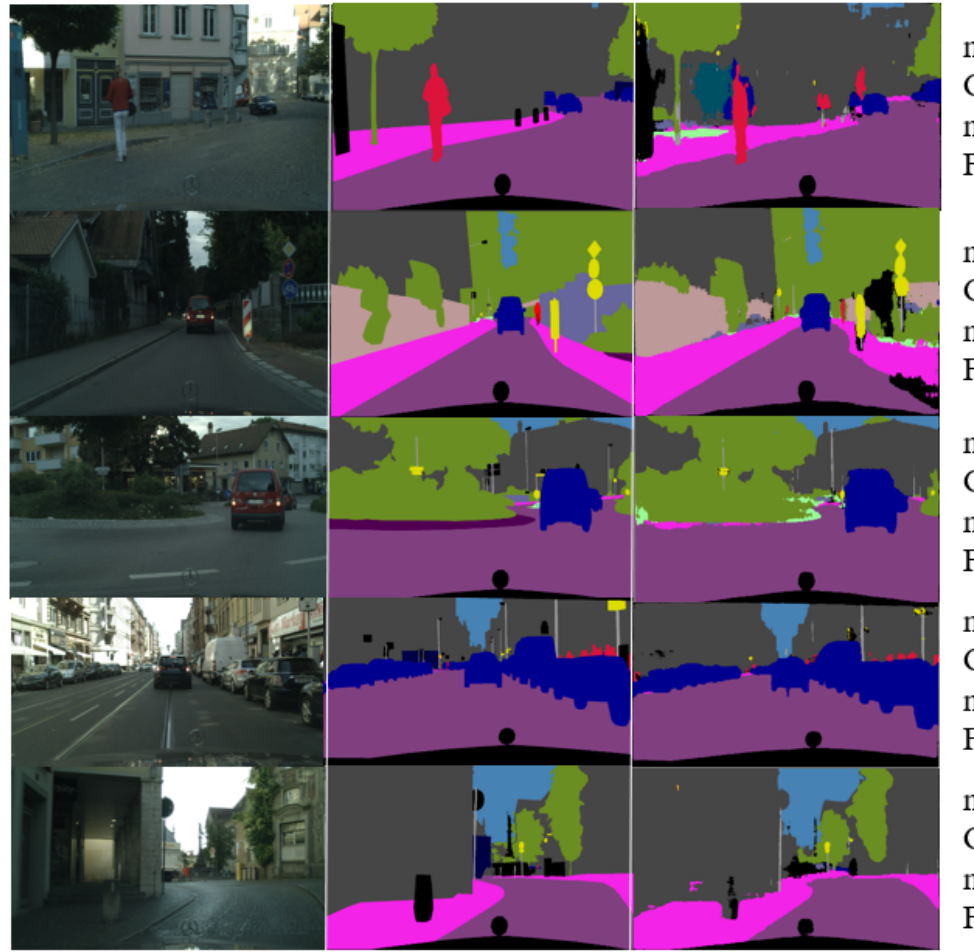
Figure 11. Examples of false-positive images in the Cityscapes